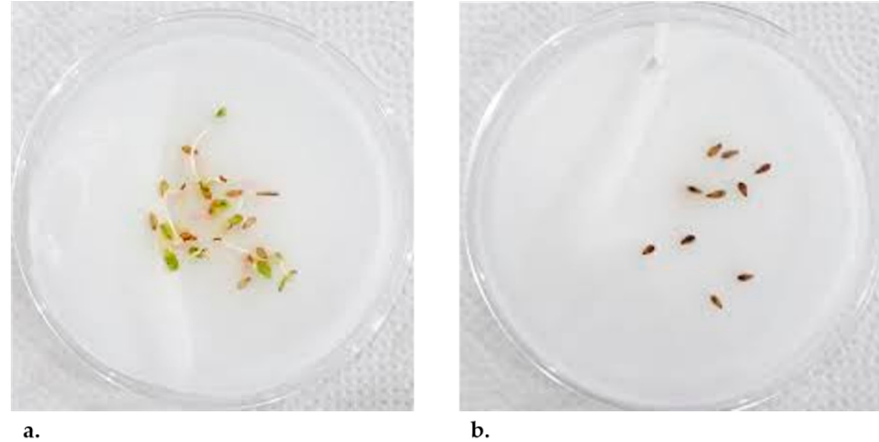
Figure 1. Petri dishes containing seeds exposed to different concentrations of cephalosporins demonstrating ( a ) Lactuca sativa seeds germinated after five days of exposure to 25 mg/L of Ceftazidime and ( b ) the absence of germination of L. sativa seeds exposed to 500 mg/L Ceftazidime.